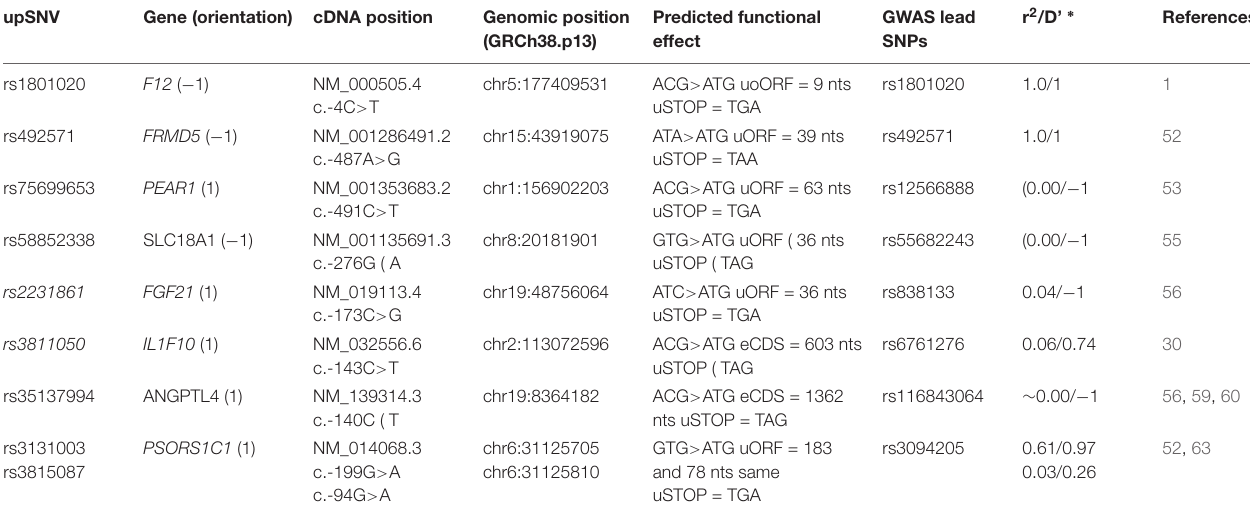
TABLE 2 | Common upSNVs in GWAS loci for CVDs and associated